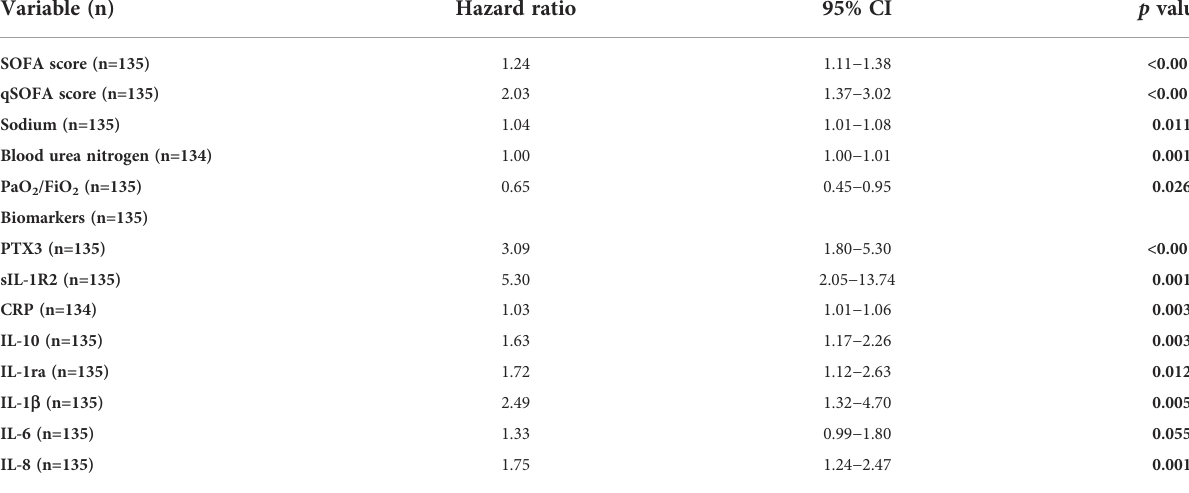
TABLE 6 Univariable Cox proportional hazard analysis of candidate predictors of 90-days